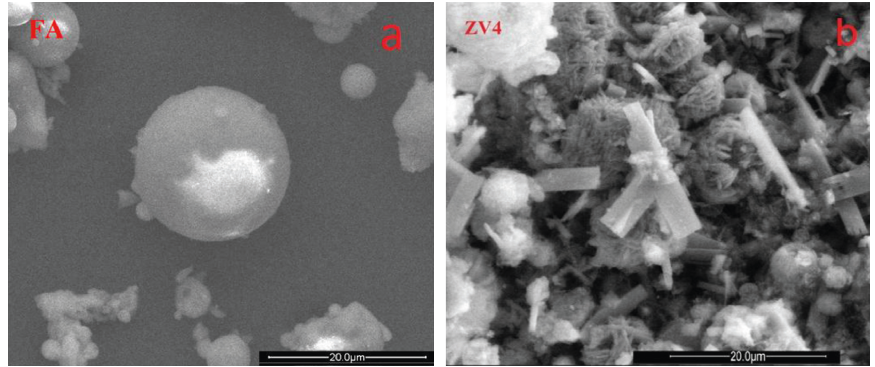
Figure 5: SEM images of fly ash and the synthesis product ZV4